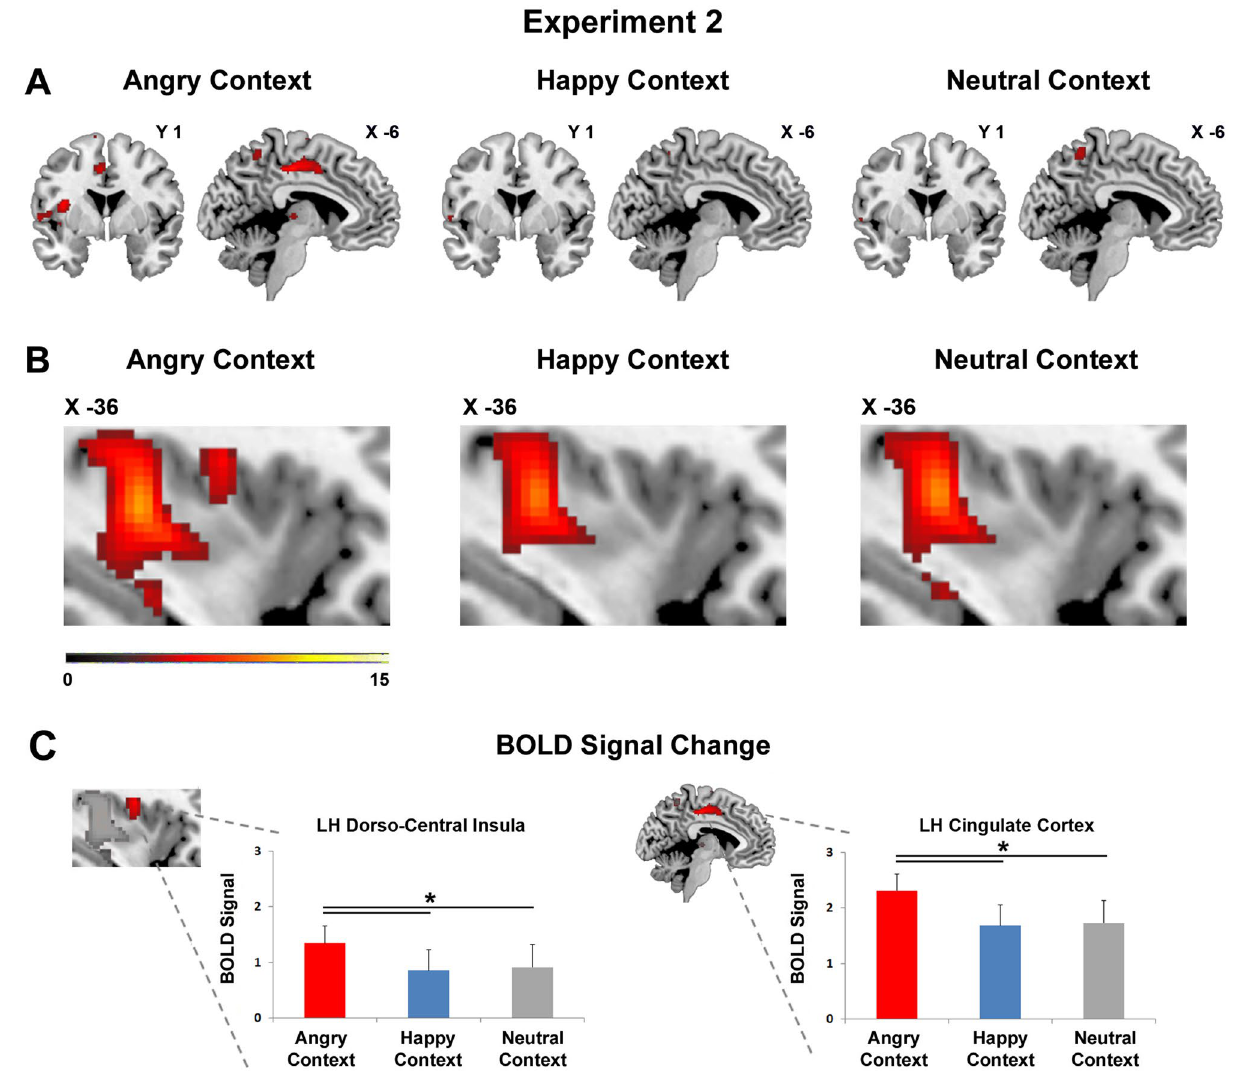
Figure 6. Parasagittal sections showing the activations of the insular and cingulate cortices modulated by the dynamic facial expressions. These brain activations are relative to the perception of handshakes obtained in situation 1 (handshake and facial expression) during the angry (Tactile Vitality Form in Angry Context), happy (Tactile Vitality Form in Happy Context), and neutral (Tactile Vitality Form in Neutral Context) contexts ( A,B ). The bar graph indicates the BOLD signal change extracted from the cluster of the left dorso-central insula and the cingulate cortex highlighted from the contrast Tactile Vitality Form in Angry Context vs. baseline ( C ). The horizontal line above the bars indicates the comparisons of the insula and cingulum activity during the handshake perception during the angry, happy, and neutral contexts. Asterisks indicate significant differences set at p ≤ 0.05 (*). The vertical lines indicate the standard error of the means (SEM). These brain activations are rendered using a standard Montreal Neurological Institute brain template (P FWE <